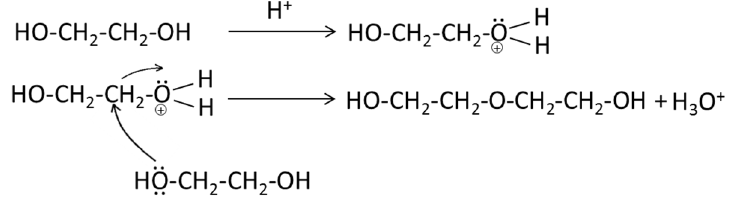
Figure 2. Acid catalyzed self-reaction of EG to form DEG. After Moghaddam et al. [31].